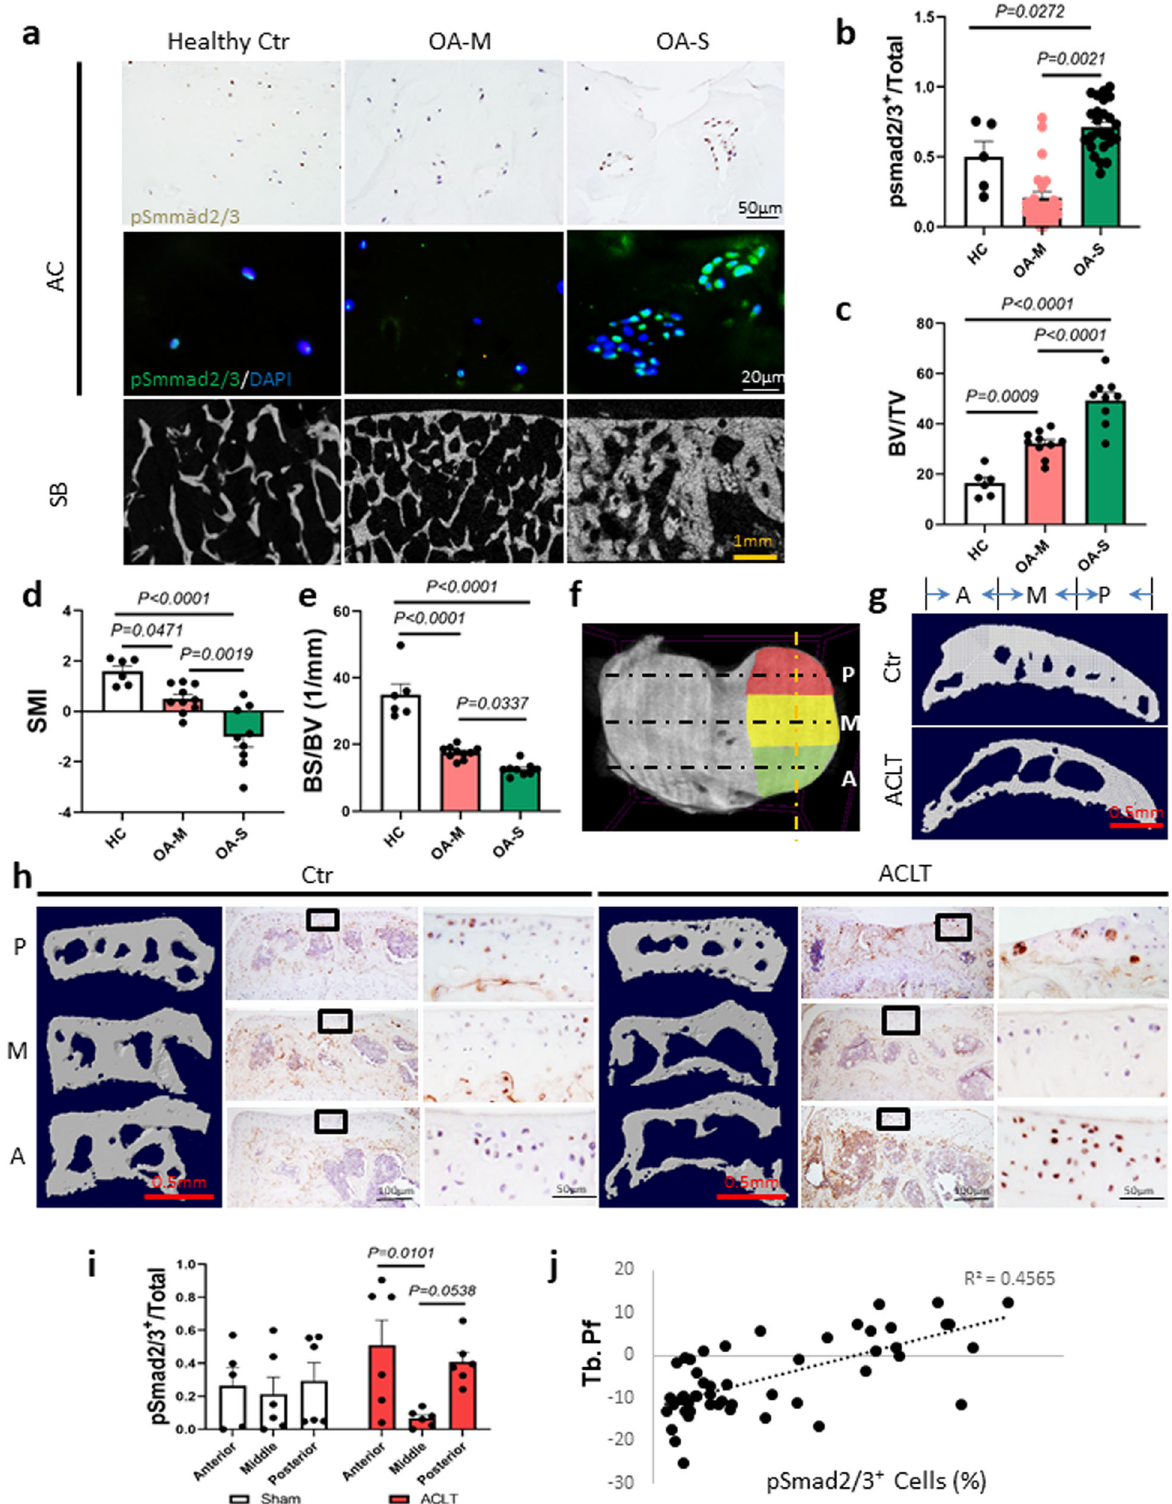
different in the anterior region, whereas the differences in the middle and posterior regions were limited (Fig. 1g, h). Histolo- gical analysis showed that the anterior region showed the earliest signs of cartilage degeneration (Supplementary Fig. 1). Similar to human OA specimens, in OA mice the distribution of TGF β activity in AC was altered signi fi cantly, whereas it was relatively